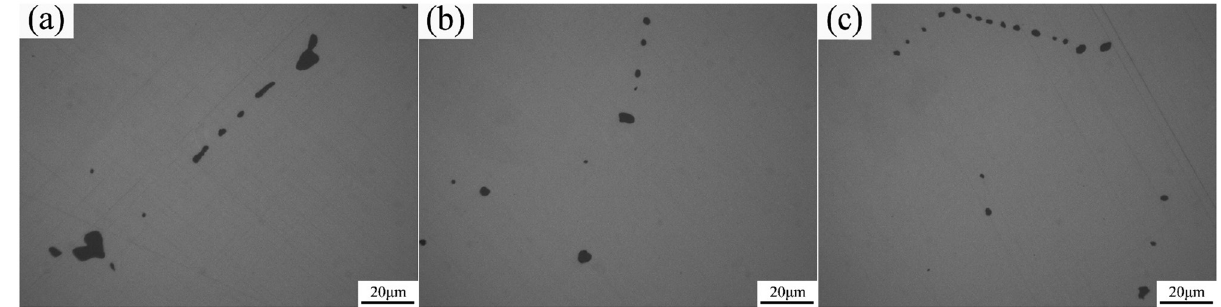
Figure 5: Variation of morphology of MnS at the 1/2R of as - cast steel with homogenization time; ( a ) 3 h, ( b ) 5 h, and ( c ) 10 h.